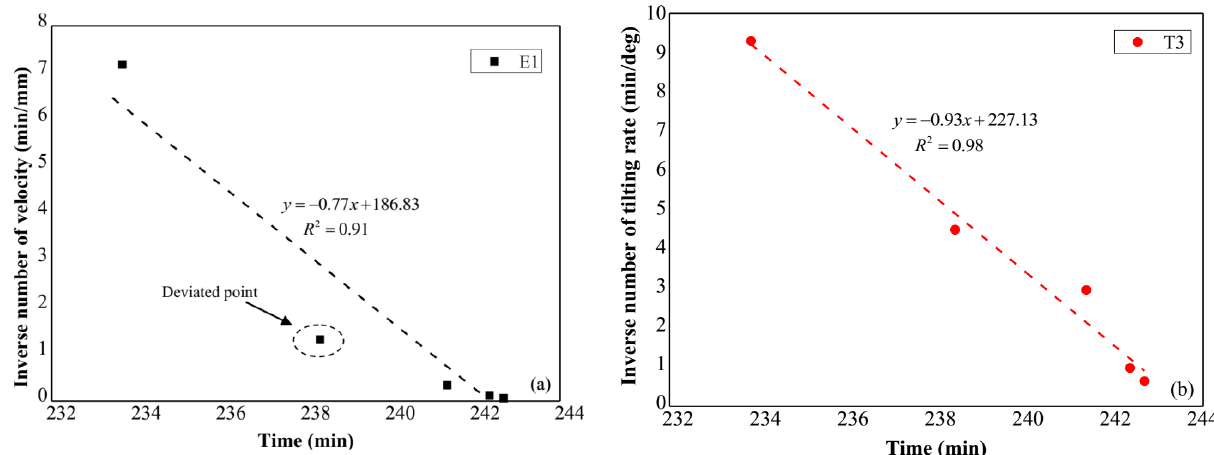
Figure 12. ( a ) Reciprocal displacement rate against time, ( b ) reciprocal tilting rate against